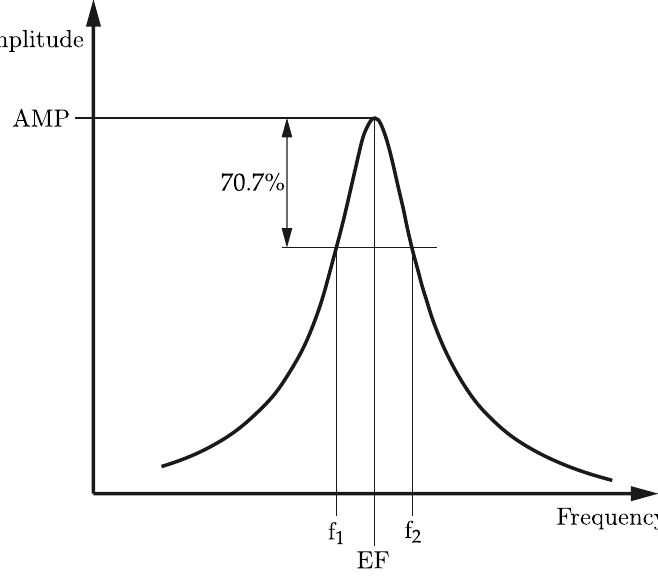
Figure 1. Schematical representation of a peak including the reference